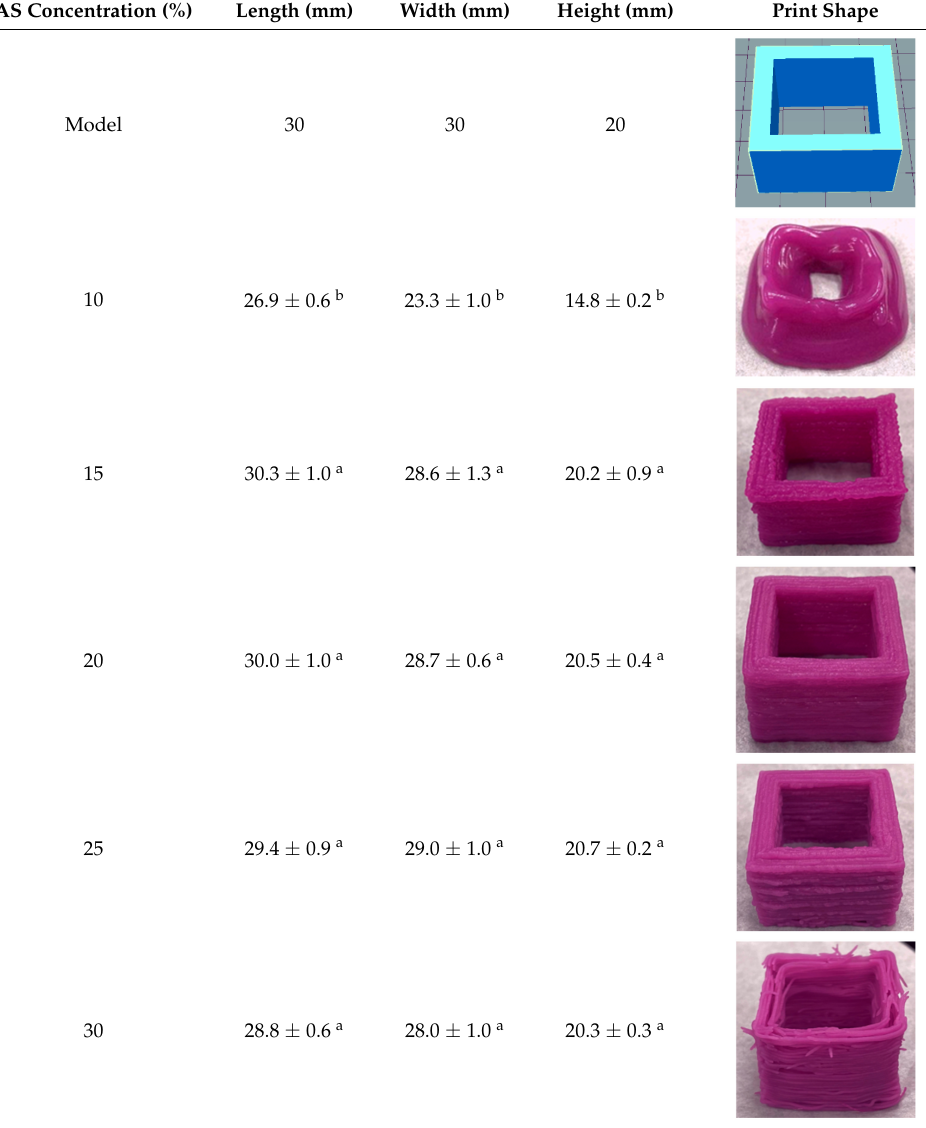
Table 5. Effect of AS concentration on 3D printing of AS gels. AS Concentration (%) Length (mm) Width